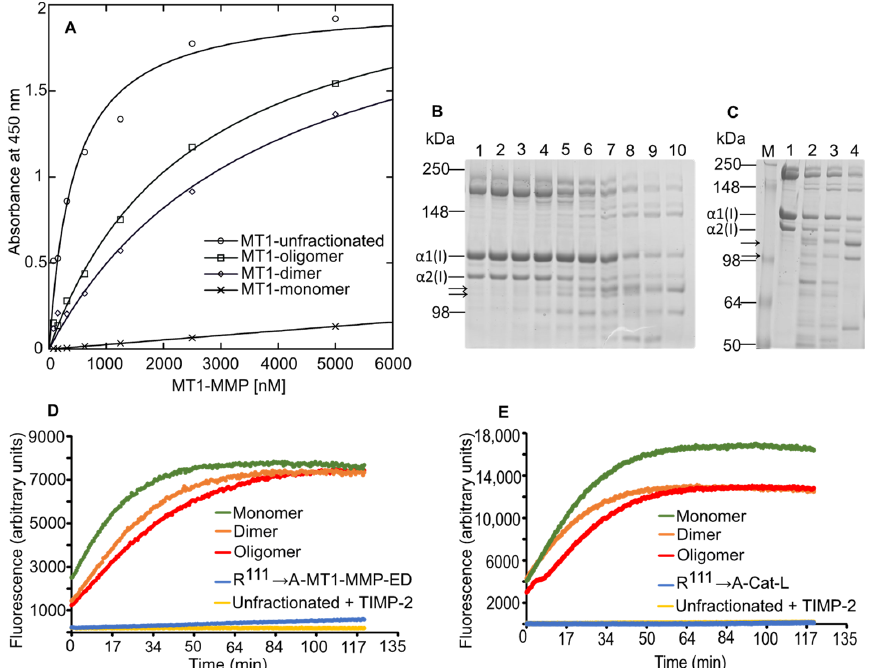
Figure 6. The multimeric structures of MT1-MMP bind to type I collagen with different affinities. ( A ) Measurement of WT-MT1-MMP-ED binding to type I collagen in ELISA. The wells of an ELISA plate were coated with 10 µ g/mL type I collagen from rat tail. Serial dilutions of WT-MT1-MMP-ED were applied to the coated wells and incubated at 20 ◦ C. The binding of WT-MT1-MMP-ED to collagen was detected with an anti-His-tag antibody conjugated with HRP. ( B ) The collagenolytic activity of unfractionated WT-MT1-MMP ectodomain. 10 µ g of rat tail type I collagen was incubated with various concentrations of WT-MT1-MMP-ED and the cleavage reaction was analyzed after 18 h post-incubation in Coomassie brilliant blue-stained SDS-PAGE. Lane 1: type I collagen without enzyme; lane 2: WT-MT1- MMP-ED incubated with CT1746 inhibitor; lanes 3 to 10: increasing concentration of WT-MT1-MMP-ED (0.5, 1, 2, 4, 8, 16, 32 and 64 nM). ( C ) The collagenolytic activity of the separated multimeric forms